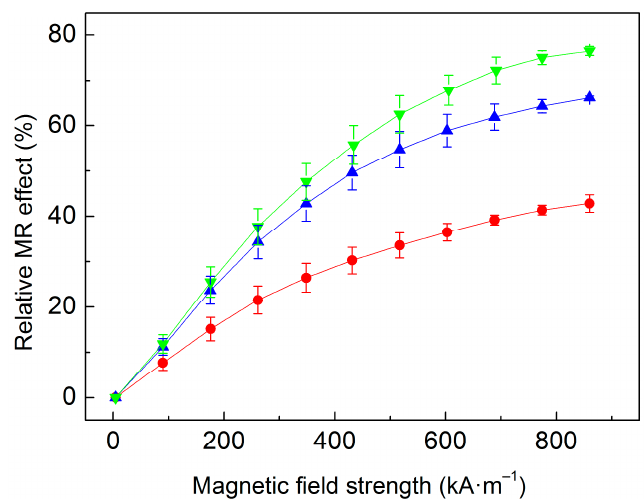
Figure 8. Relative MR effect of the MREs containing bare CI ( red circles ), CI ‐ g ‐ PHEMATMS ‐ 1 ( blue up ‐ triangles ), and CI ‐ g ‐ PHEMATMS ‐ 2 ( green down ‐ triangles ) particles as a function of applied magnetic field strength.